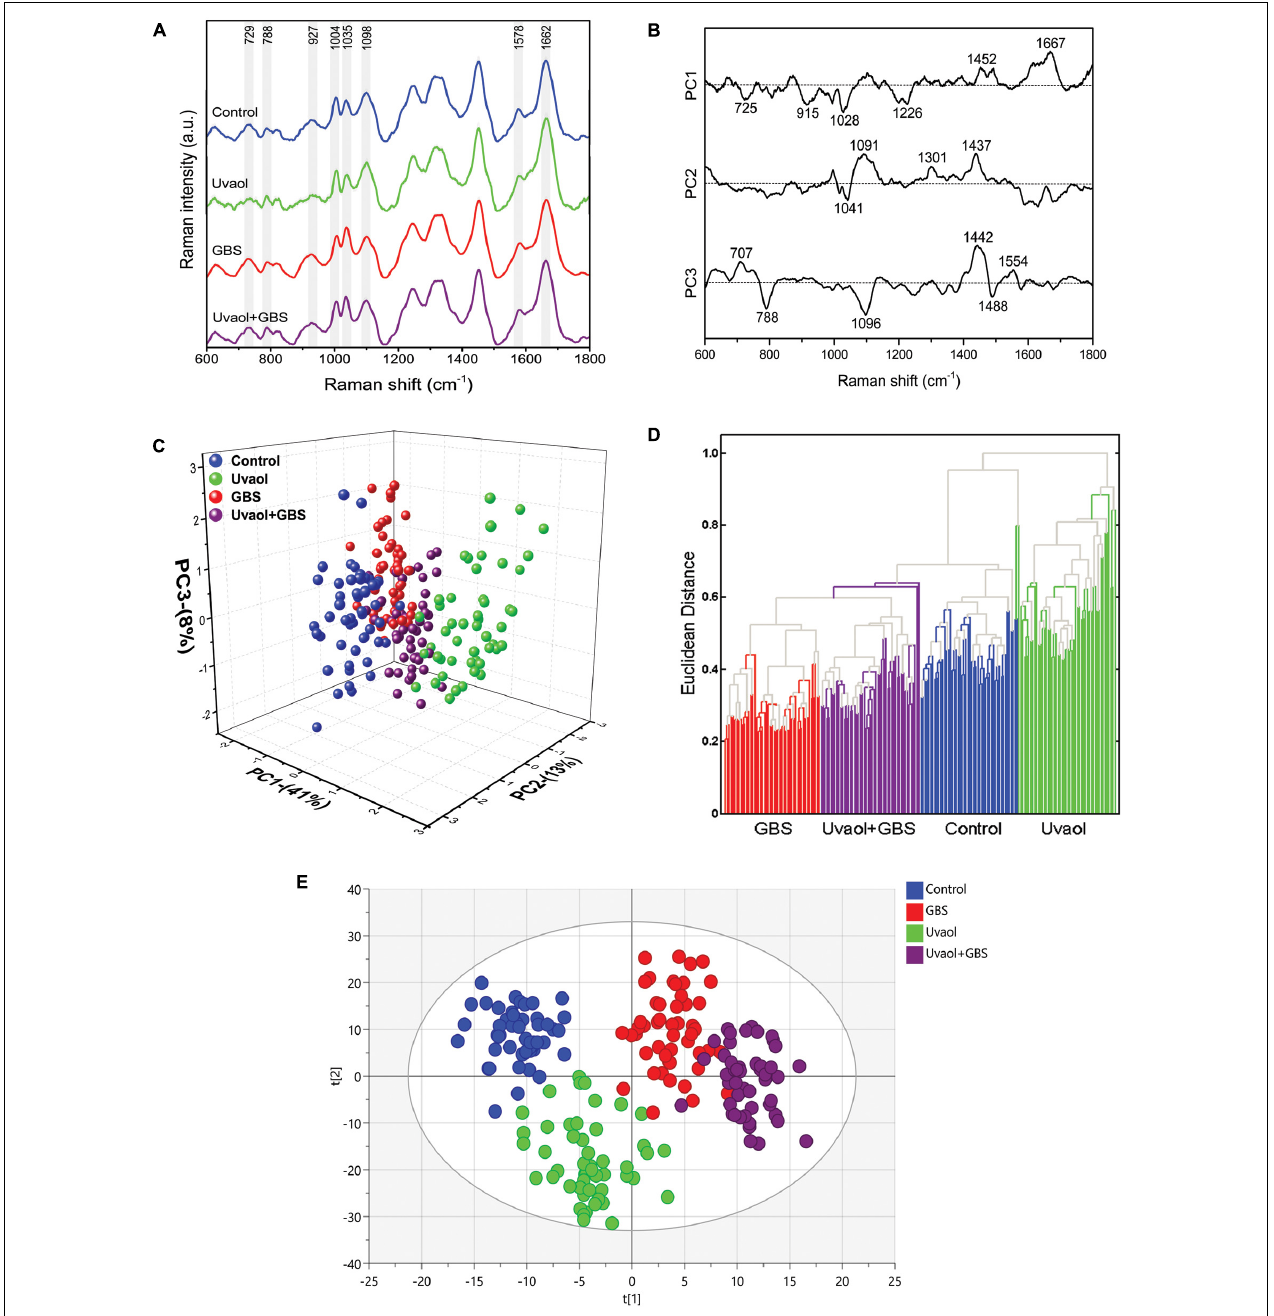
FIGURE 2 | GBS and uvaol change trophoblast cells biochemical signature. (A) The Raman spectra represent the averages of 50 cells for each group (Control, uvaol 10 µ M, GBS at 10 6 CFU, and uvaol with GBS) in the fingerprint region (600–1,800 cm − 1 ). The shaded areas correspond to the Raman bands where the main variances observed in the average cell spectra occurred; (B) Loadings of PC1, PC2, and PC3 for Control, uvaol, GBS, and uvaol + GBS groups; (C) A three-dimensional PCA score plot; (D) HCA dendrogram for all analyzed groups; (E) A two-dimensional OPLS-DA score plot of the Raman spectra for the Control, uvaol, GBS, and uvaol + GBS groups. The four groups were relatively well-discriminated along the t[1] axis, as well along the t[2] axis. N =